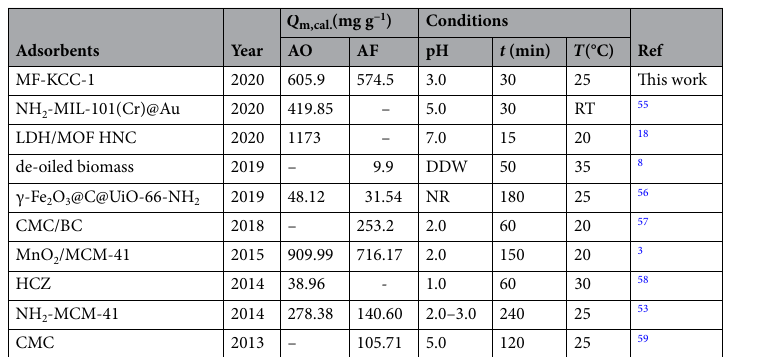
Table 3. Maximum adsorption capacities for AF and AO by various adsorbents (NR: not reported; DDW: double distilled water; RT: room temperature). Biomass: Sargassum myriocystum ; CMC/BC: carboxymethyl- chitosan/bentonite composite; CMC: chemically modified cellulose; HCZ: hexadecyltrimethylammonium bromide coated